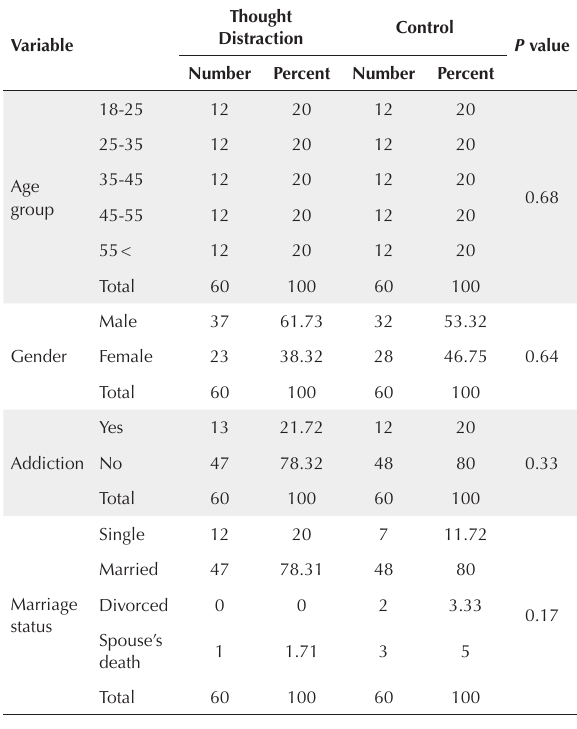
Table 1. Demographic characteristics of patients